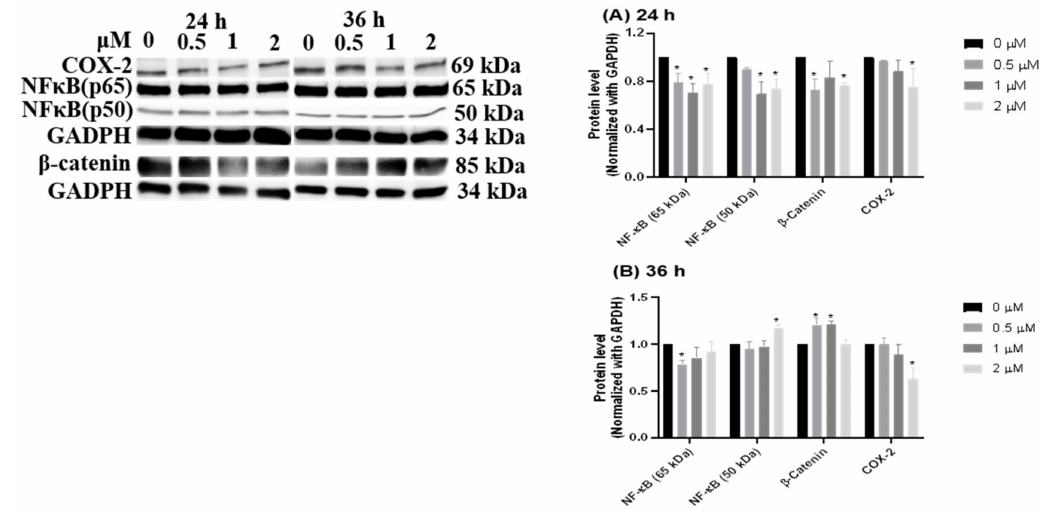
Figure 7. Inflammation-related protein changes after HCD treatments. NF- κ B, β -catenin, and Cox-2 were determined by Western blotting at ( A ) 24 h and ( B ) 36 h HCD-treated Caco-2 cells. The chemiluminescent intensity of each protein was normalized with GAPDH and represented as the protein levels. Data ( n = 3) were represented as mean ± SD. * p < 0.05 as compared with the untreated control (0 µ